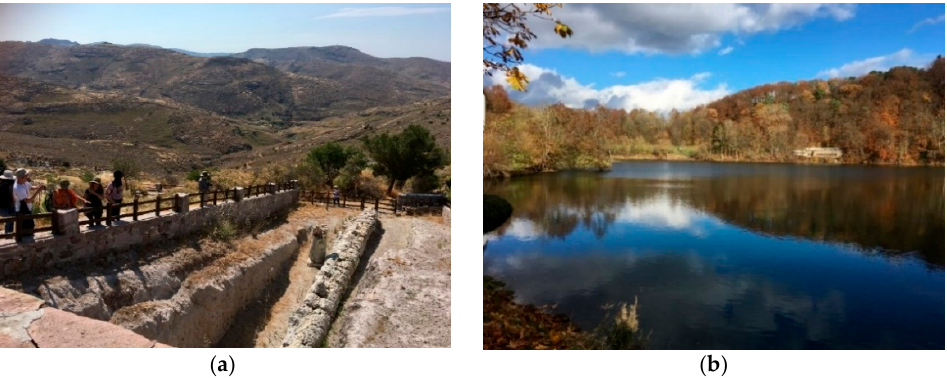
Figure 2. ( a ) Lesvos UGGp, Greece—Giant tree in the Petrified Forest in Sigri, Lesvos. ( b ) Vulkaneifel UGGp, Germany—Ulmen Maar Crater Lake.